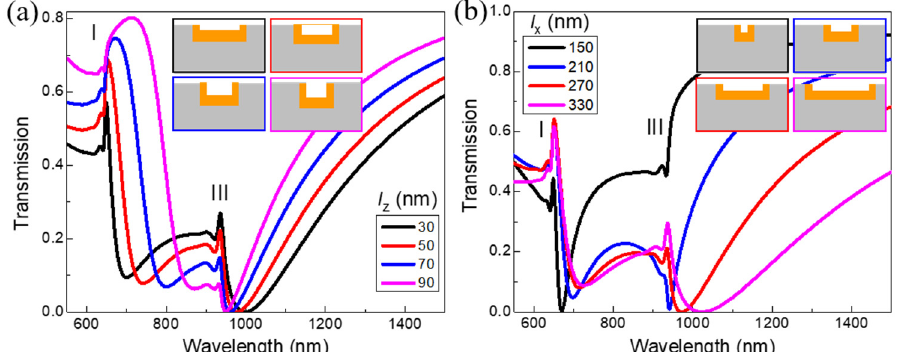
Figure 4. ( a ) The calculated transmission spectra of the Au VSRRs array embedded in the silica substrate for different l z under normal incidence of light for TM polarization. The whole length (2 l z + l x ) of VSRR, t x , t z and P are kept as 370 nm, 20 nm, 20 nm and 650 nm, respectively. ( b ) The calculated absorption spectra for different l x under normal incidence of light for TM polarization. Here, l z , t z , t x and P are kept as 40 nm, 20 nm, 20 nm and 650 nm, respectively.